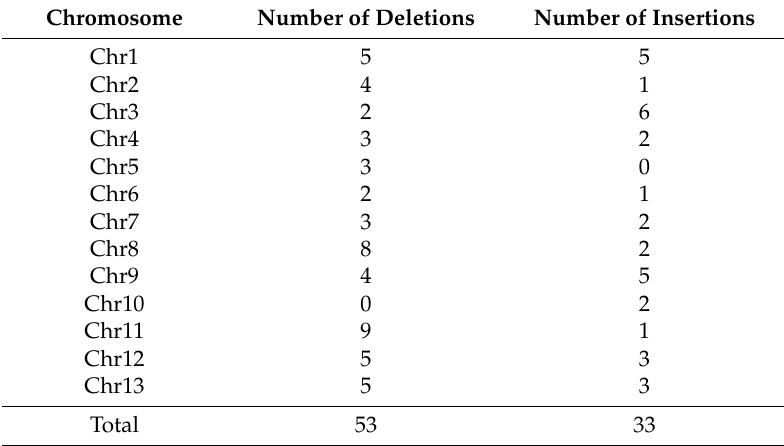
Table 3. Distribution of insertions-deletions of length ≥ 8 bp in the genome.